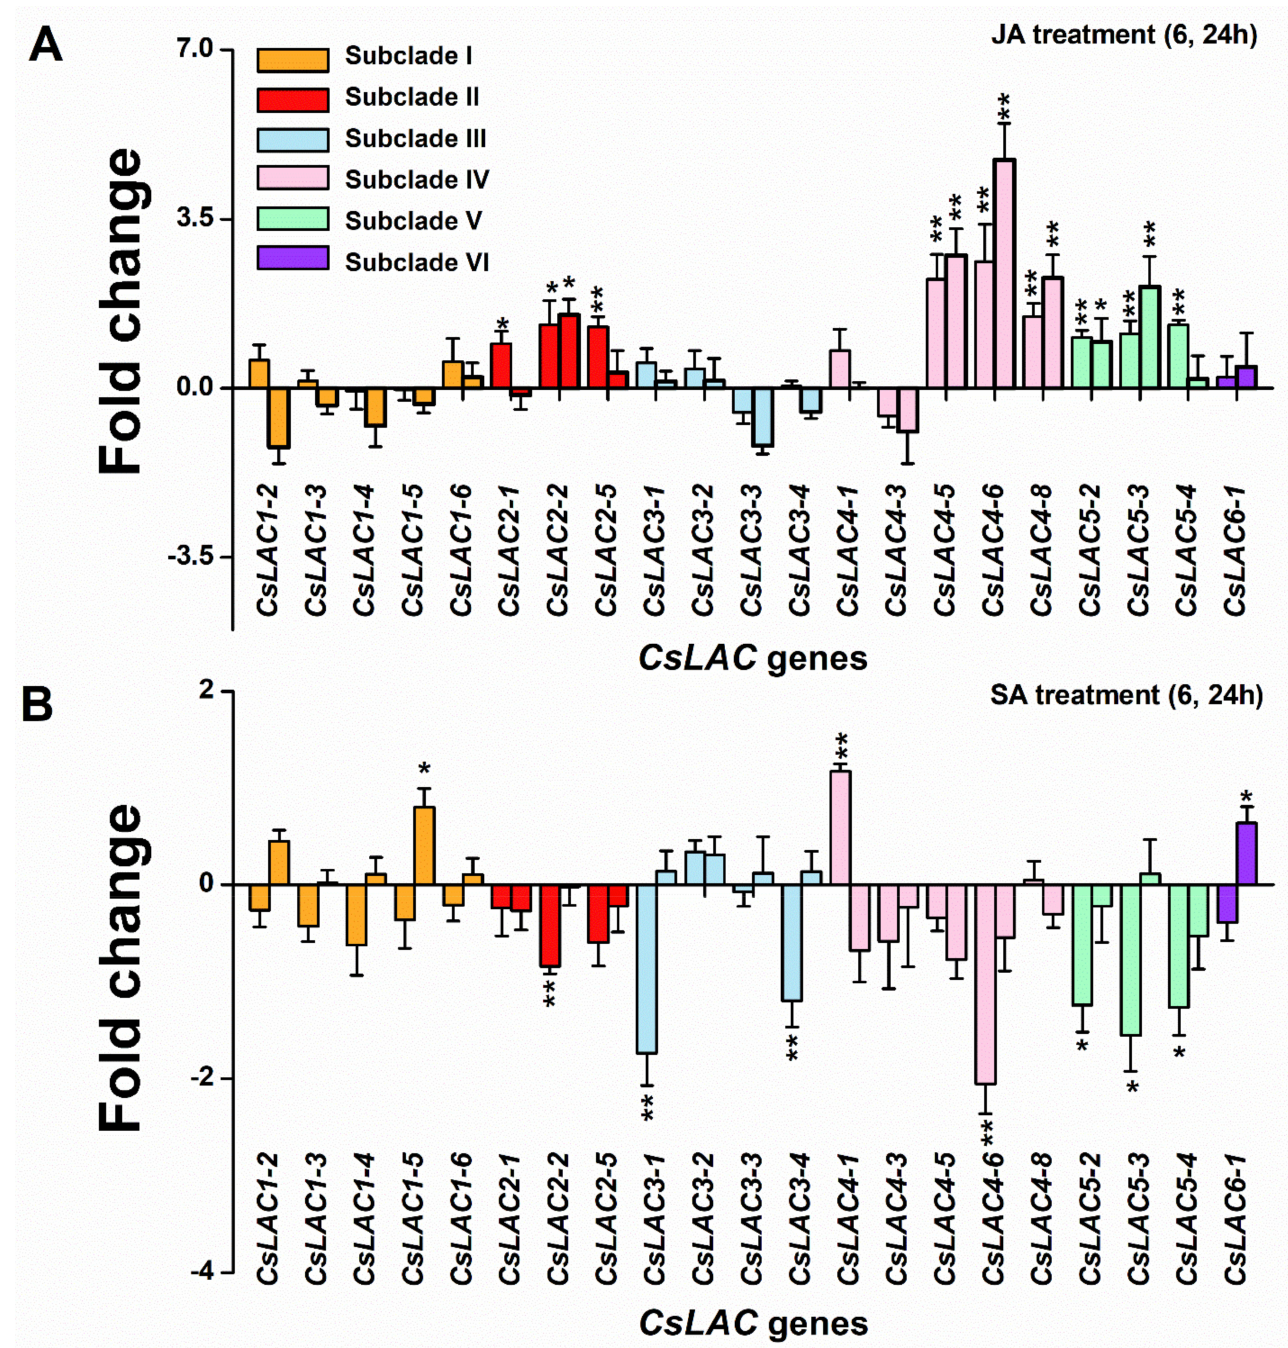
Figure 7. Expression patterns of differentially expressed CsLAC s from C. sinensis cv ‘Longjing43 (cid:48) cultivars treated with jasmonic acid (JA) and salicylic acid (SA). The fold change in expression levels (treated group vs. control group) is shown on a log2 scale and the left and right bar graphs for each gene represent the fold change after 6h and 24h of treatment, respectively. ( A ) The change in expression levels of CsLAC s in response to JA treatment by RT-qPCR. ( B ) The change in expression levels of CsLAC s in response to SA treatment by RT-qPCR. The asterisks above lines indicate significant differences between the herbivore treatment and the control (*, p < 0.05, **, p < 0.01, Student’s t